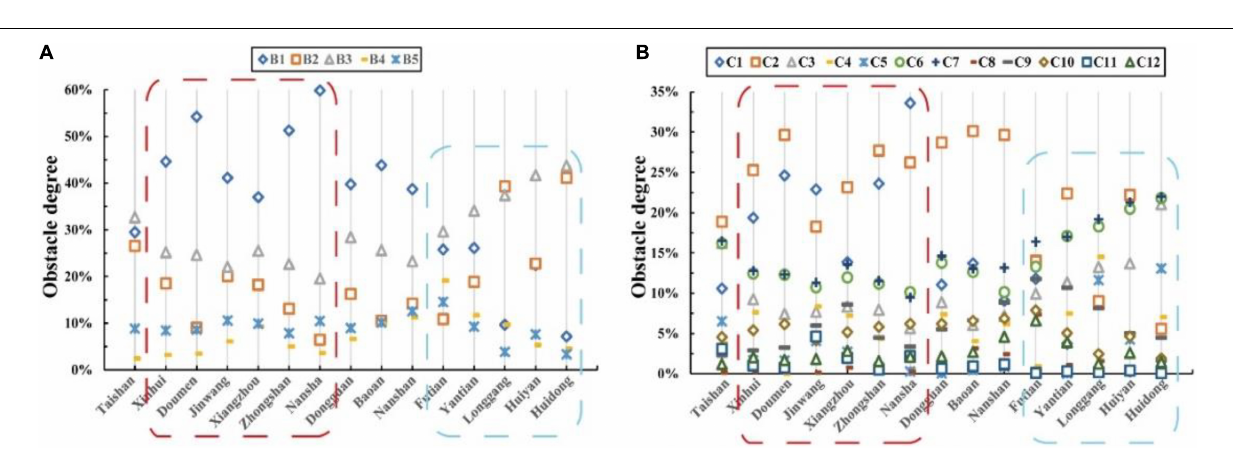
FIGURE 6 | Obstacle degree model analysis of the main elements (A) and indices (B) that influence coastal erosion in 15 counties and districts and the distribution of coastal characteristic differences in the study area (average of 5 periods). The scope of the high vulnerability area and low vulnerability area is the same as that in Figure 3 . The specific meaning of the characters in the figure and the corresponding relationship between factors are shown in phase 1 of Figure 2 .